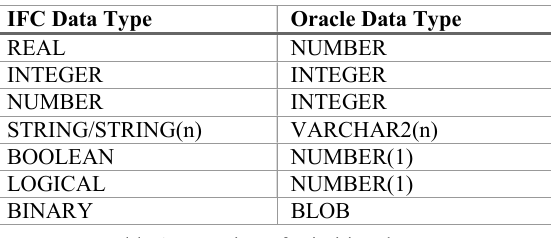
Table 1. Mapping of primitive data type